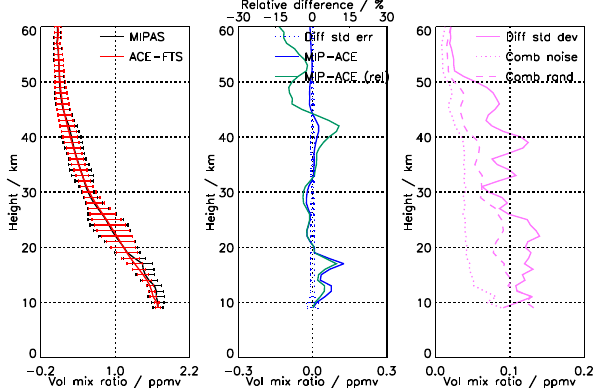
Figure 8. Comparison between volume mixing ratios of N 2 O from HATS and MIPAS reduced resolution (V5R_N2O_224 and V5R_N2O_225). Details as in Fig. 4.